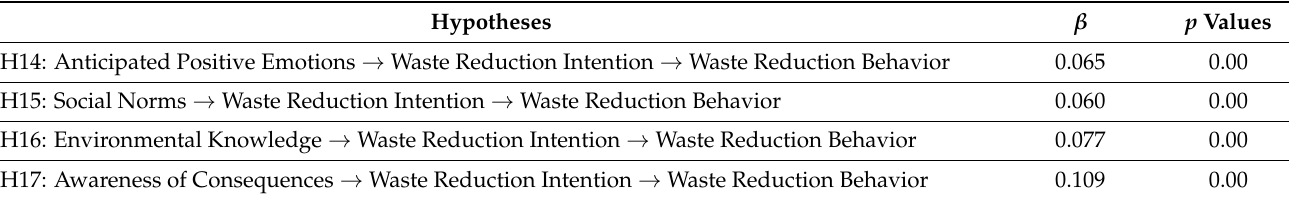
Table 7. Indirect